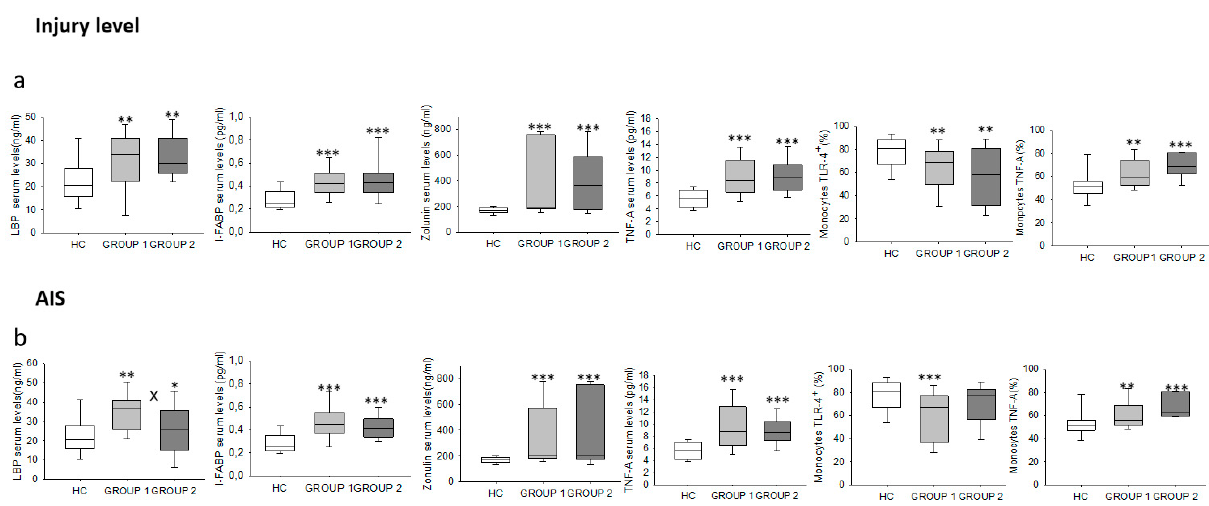
Figure 7. Clinical stratification of chronic SCI patients. Different immune system parameters (LBP, I-FABP, zonulin, serum TNF- α , TLR4 and TNF- α -producing monocytes) in chronic SCI patients (gray box) and healthy controls (white box) were analyzed. Patients were stratified by the level of the spine lesion: ( a ), from C1 to T5 (Group 1) versus from T6 to L6 (Group 2), and by the AIS score; ( b ), as follows: group 1 covers A and B AIS scores, and group 2 covers C, D and E AIS scores. * Significant difference between patients and healthy controls ( p < 0.05). ** Significant difference between patients and healthy controls ( p < 0.01). *** Significant difference between patients and healthy controls ( p < 0.001). X Significant difference between both groups of patients ( p <